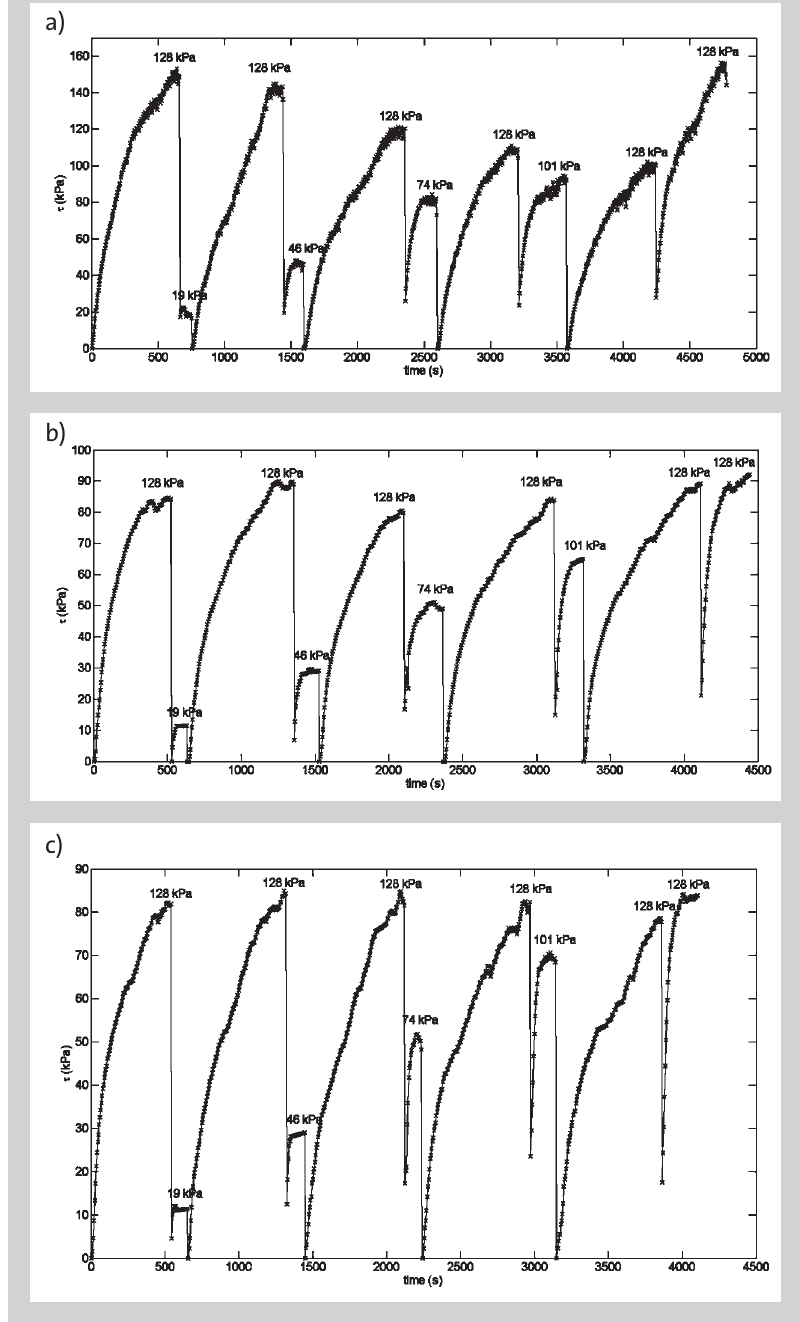
Figure 3: Typical shear stress-time curves observed during the shear testing of the materi- als studied with consolida- tion stress s = 128 kPa: c a) soya, b) colza, and c)